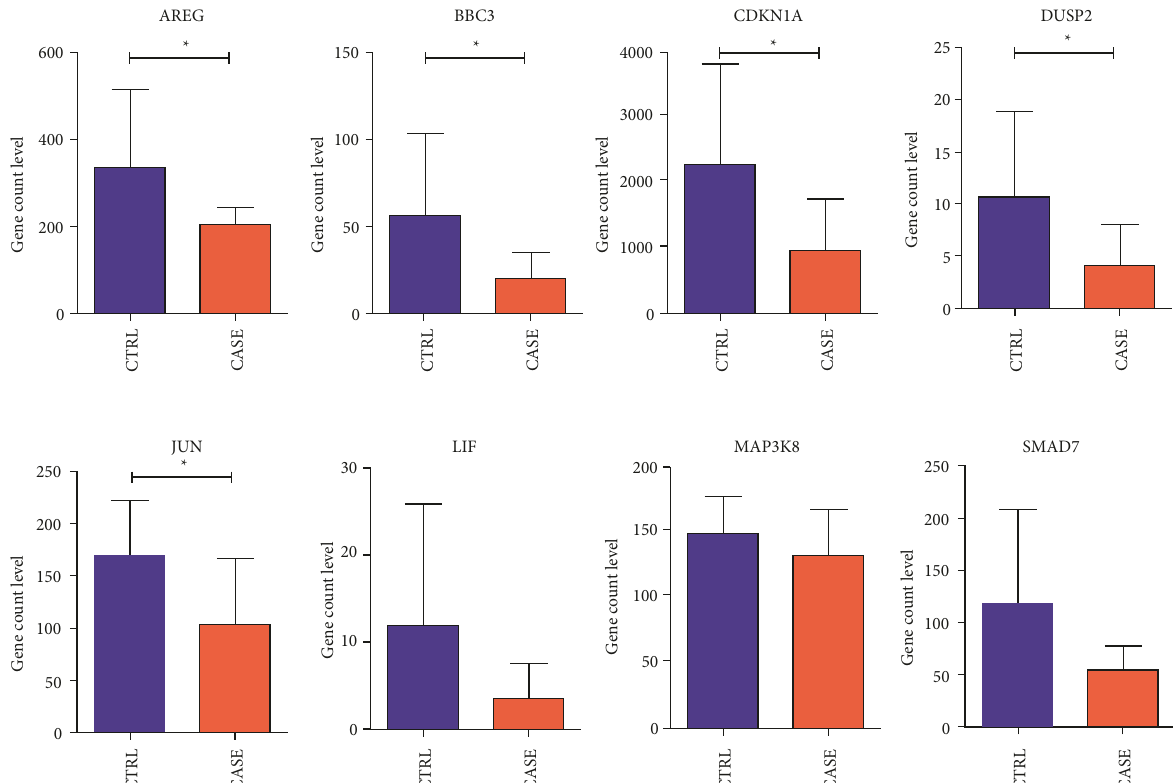
Figure 11: We visually displayed the expression levels of 8 genes in the validation data set GSE112155, as shown in Figure 11.